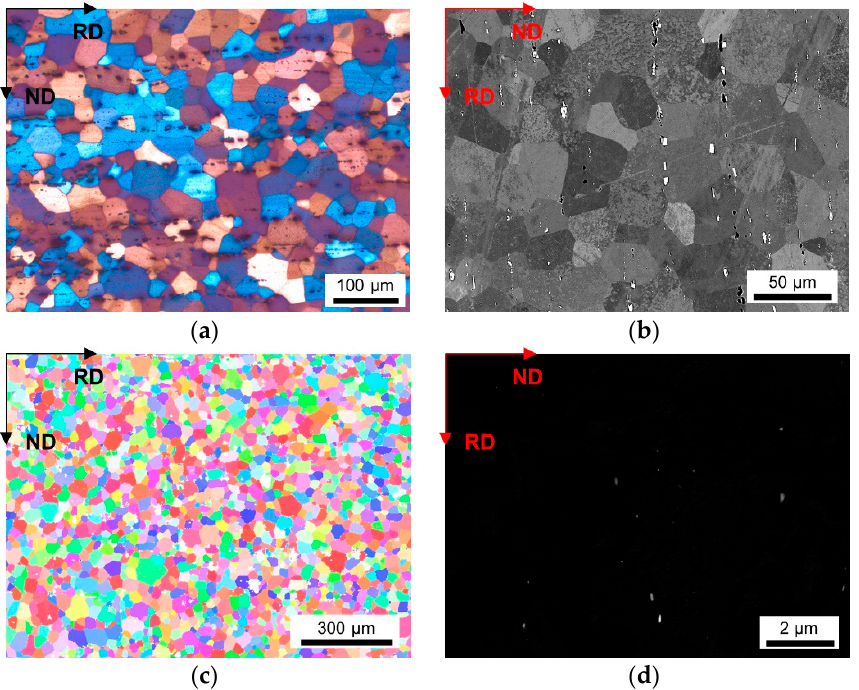
Figure A16. Microstructure of the soft annealed HFe-LMn cast under S-C conditions, homogenized at 500 °C and cold rolled to a CRD of 35%. ( a ) LOM. ( b ) BSE image. ( c ) EBSD IPF map in RD–ND plane. ( d ) BSE micrograph showing dispersoids.